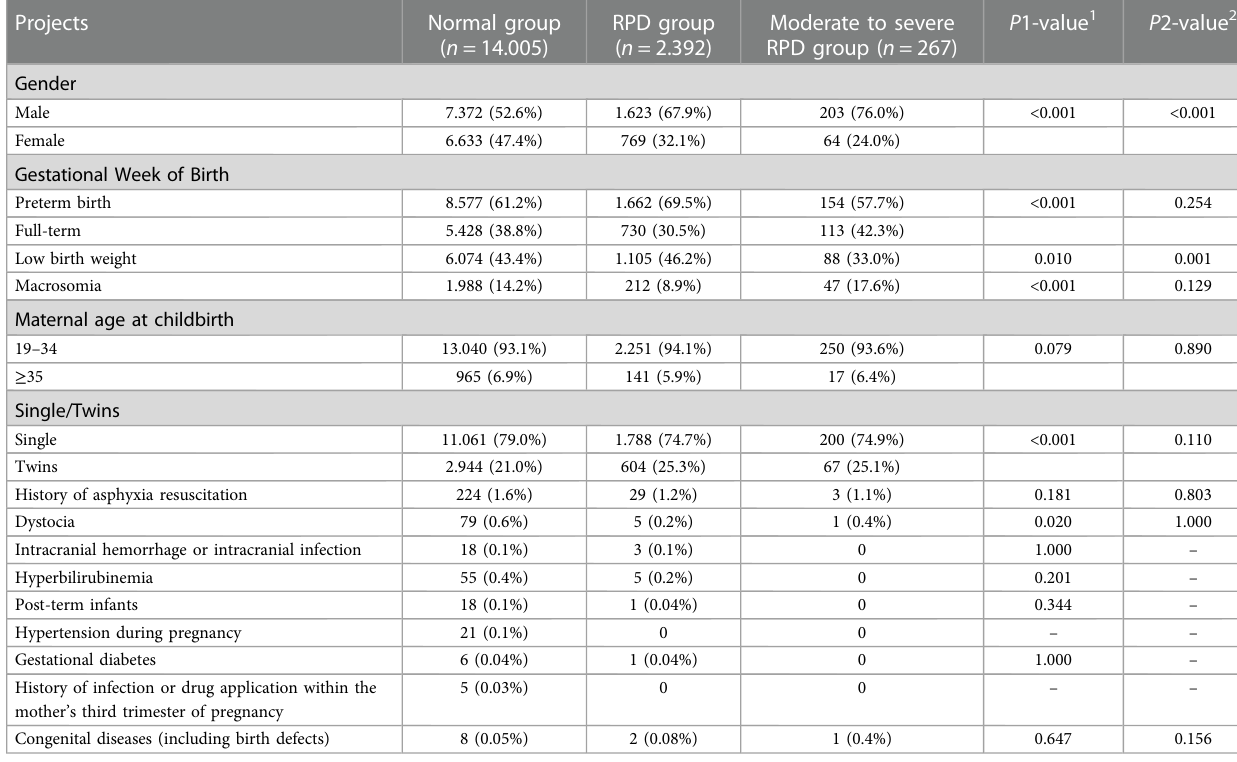
TABLE 3 Comparison of risk factors between normal and RPD groups, and moderate to severe RPD groups.